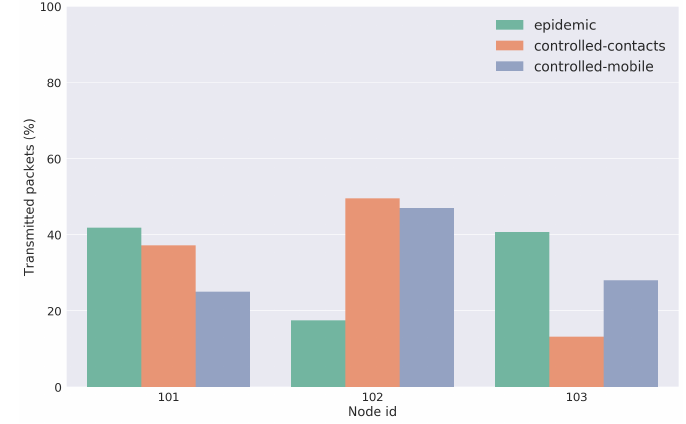
Figure 17. Results of overall transmitted data packets to other mobile